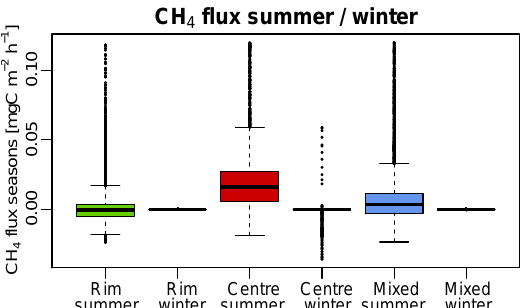
Figure 1. Modelled water table at rim and centre. Solid lines indi- cate 1 January; dashed lines indicate 1 April, 1 July and 1 October of the respective year. Only the summer periods are shown, which means less than 5cm of snow are on the ground.